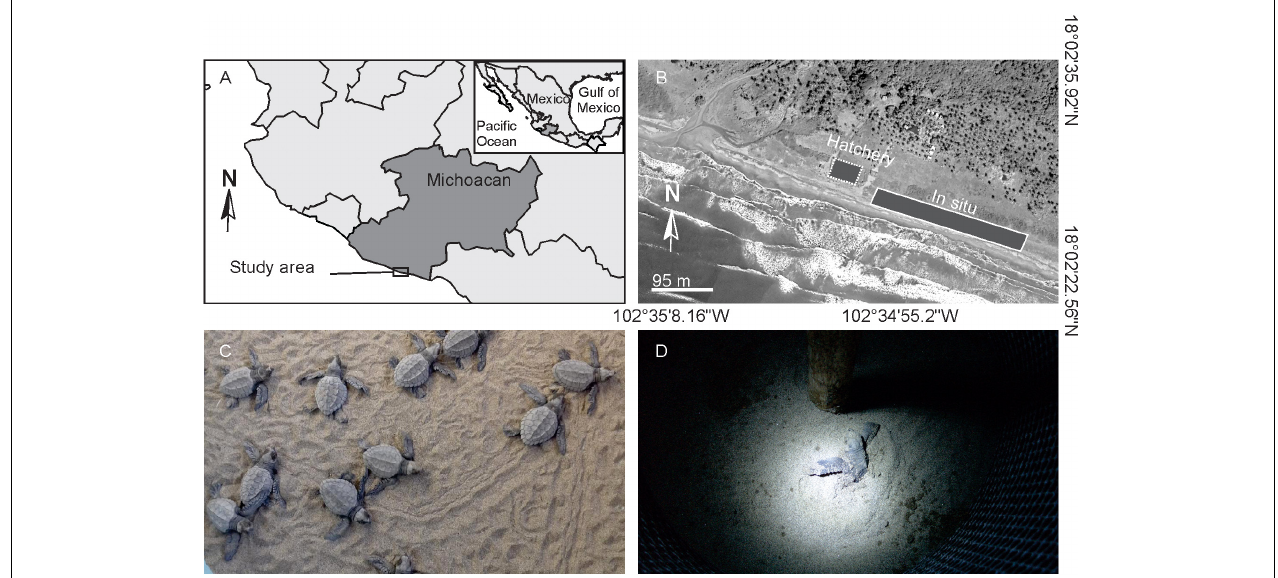
FIGURE 1 | Location of the study site and nesting conditions. (A) Map showing Lázaro Cárdenas nesting beaches in Michoacán, México. (B) Aerial photograph of ex situ (dotted line) and in situ nests (continuous line). (C,D) Lepidochelys olivacea hatchlings crawling to sea and emerging from nest,